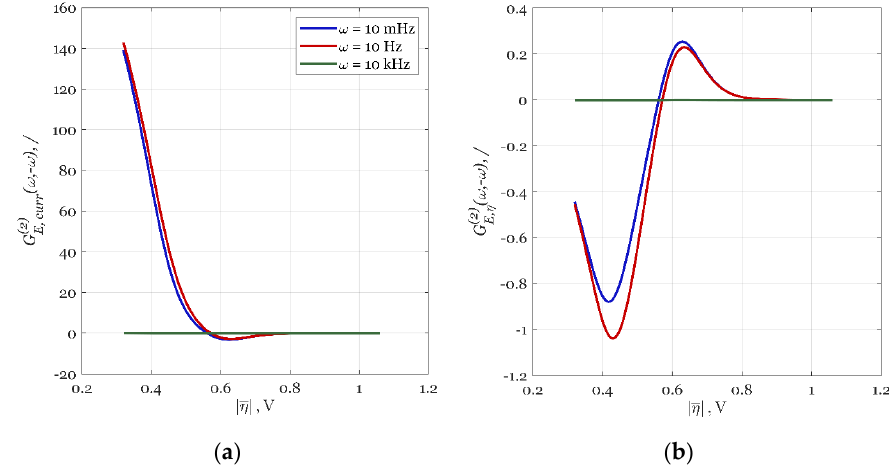
Figure A1. The oxygen reduction reaction (ORR) enhancement potential as a function of time-average overpotential (CI) at three different modulation frequencies (10 mHz as blue, 10 Hz as red, and 10 kHz as a green line): ( a ) the second ‐ order asymmetrical frequency response function (FRF) for current density and ( b ) the second ‐ order asymmetrical FRF for overpotential.